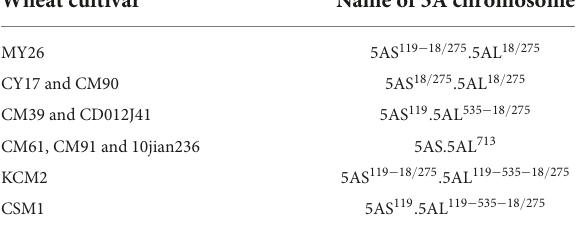
TABLE 1 The name of the 5A chromosomes in the ten wheat cultivars.